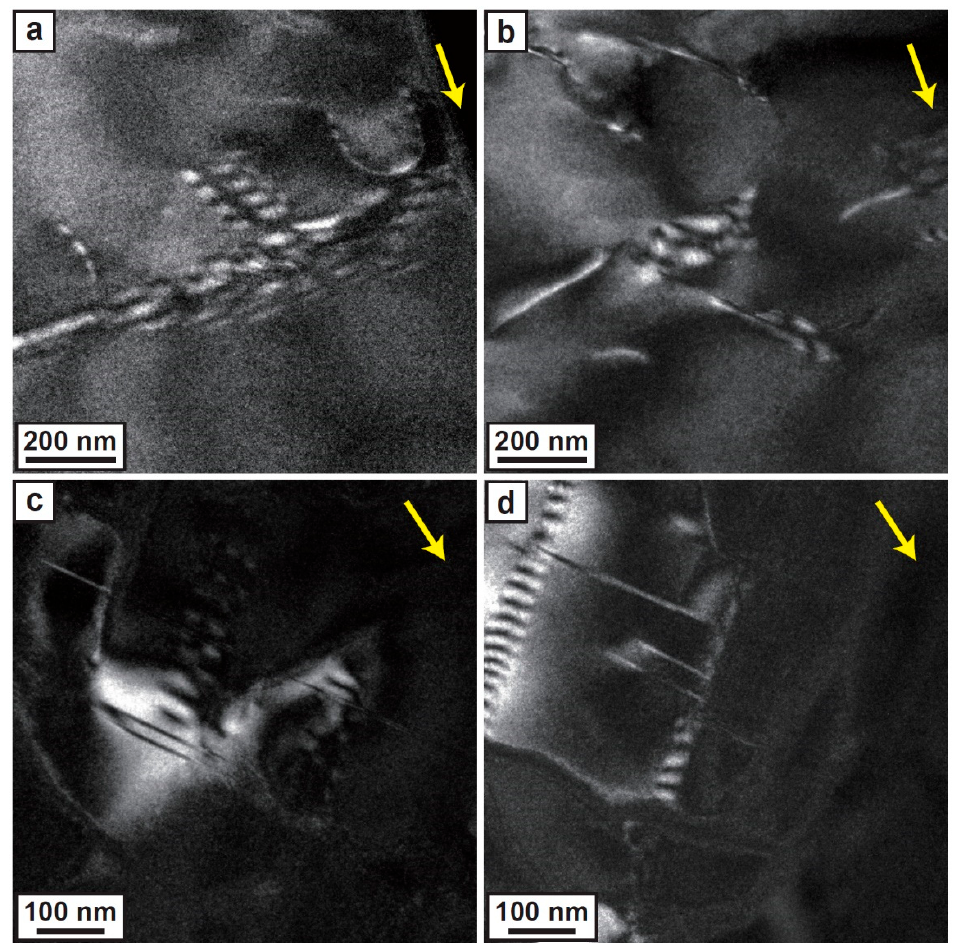
Figure 7. Weak-beam dark field (WBDF) images of glaucophane experimentally deformed with ( a , b ) low shear strain ( γ = 0.6) at P = 1.5 GPa, and T = 500 °C (JH98b) and with ( c , d ) high shear strain ( γ = 4.5) at P = 1.5 GPa, and T = 400 °C (JH94a). Yellow arrows indicate shear direction in the images. P: pressure; and T: temperature.